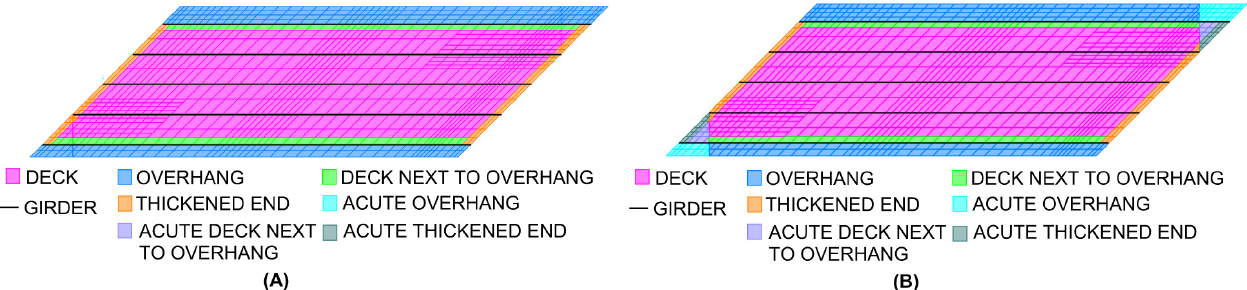
Figure 8. The definition of shell sections for deck model with ( A ) typical reinforcement at the acute corner (45 degree model only) and ( B ) modified reinforcement at the acute corner (all skew angles).